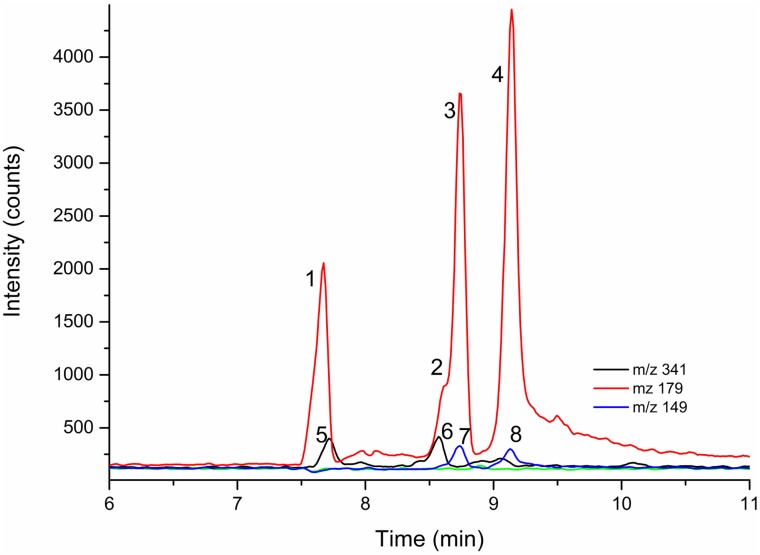
Typical electropherogram of V. rufa crude extract.(A) Electropherogram and (B) CE-MS spectrum of the V. rufa crude extract (obtained as described in the Materials and methods). The hexose sugars inositol (1), galactose (2), glucose (3), and fructose (4) were detected at m/z 179. Sucrose (5) and another disaccharide (6) were detected at m/z 341. Arabinose (7) and xylose (8) were detected at m/z 149.